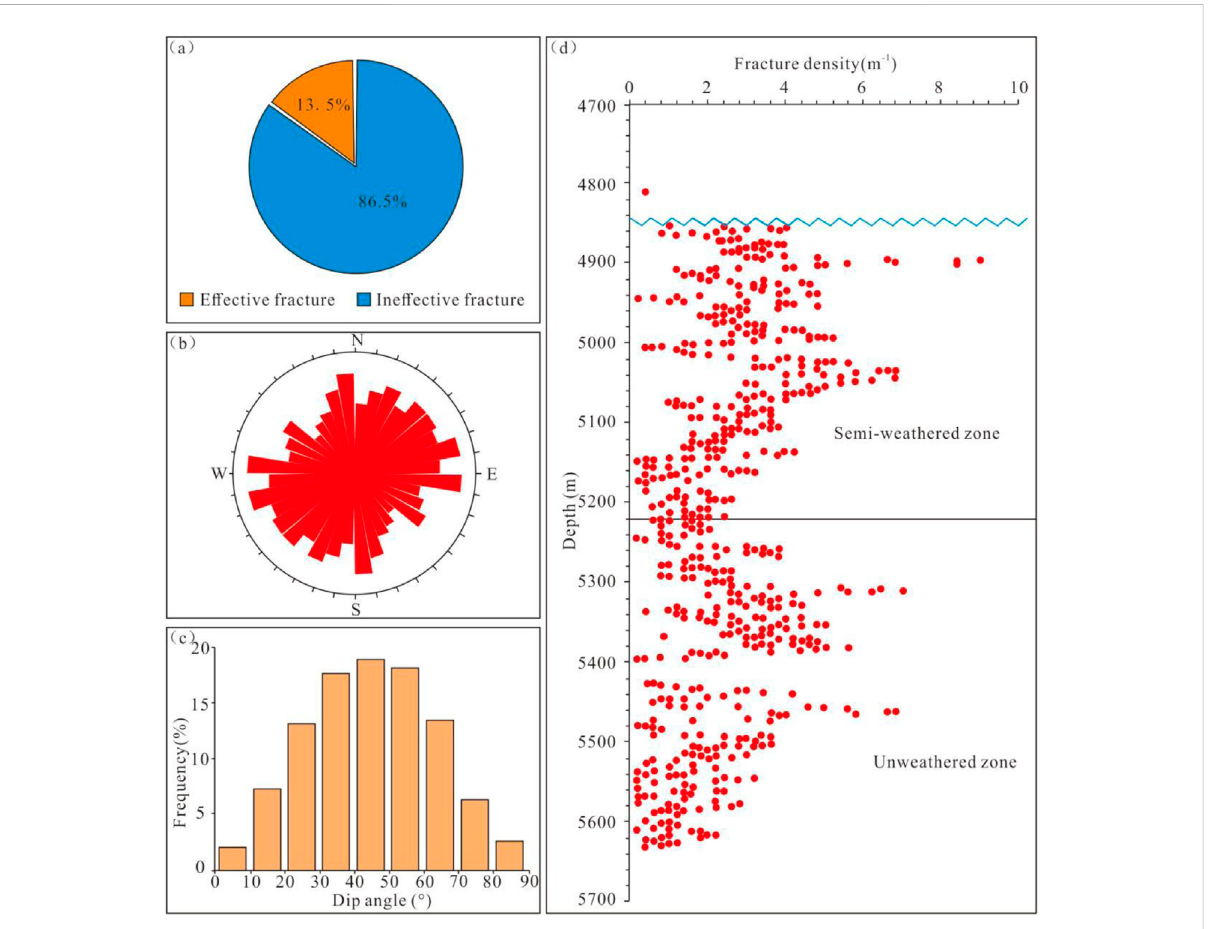
FIGURE 4 Quantitative characterization of fracture parameters and fracture distribution on imaging log. (A) Pie chart of fracture effectiveness. (B) Rose diagram of fracture strikes. (C) Diagram of dip angle distribution. (D) Fracture intensity and distribution in